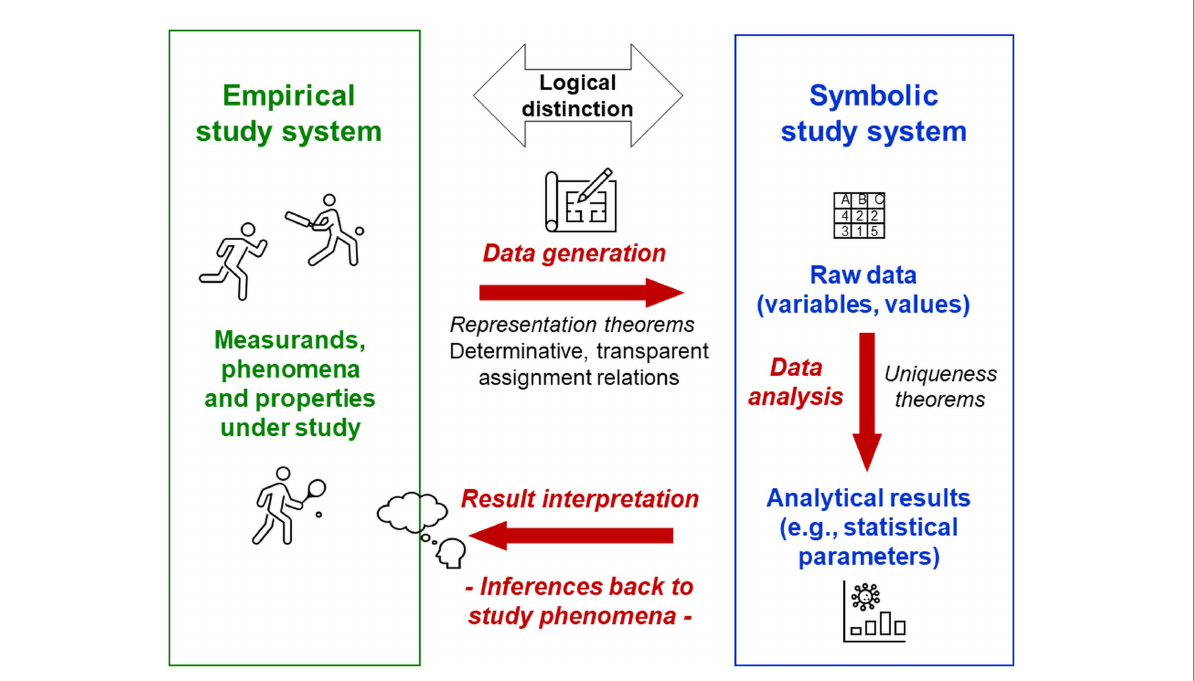
FIGURE 6 Data generation, data analysis and result interpretation. The principles of data generation traceability and numerical traceability specify rationales by which transparency can be established in the relations between the empirical study system (e.g., persons’ behaviours) and the symbolic